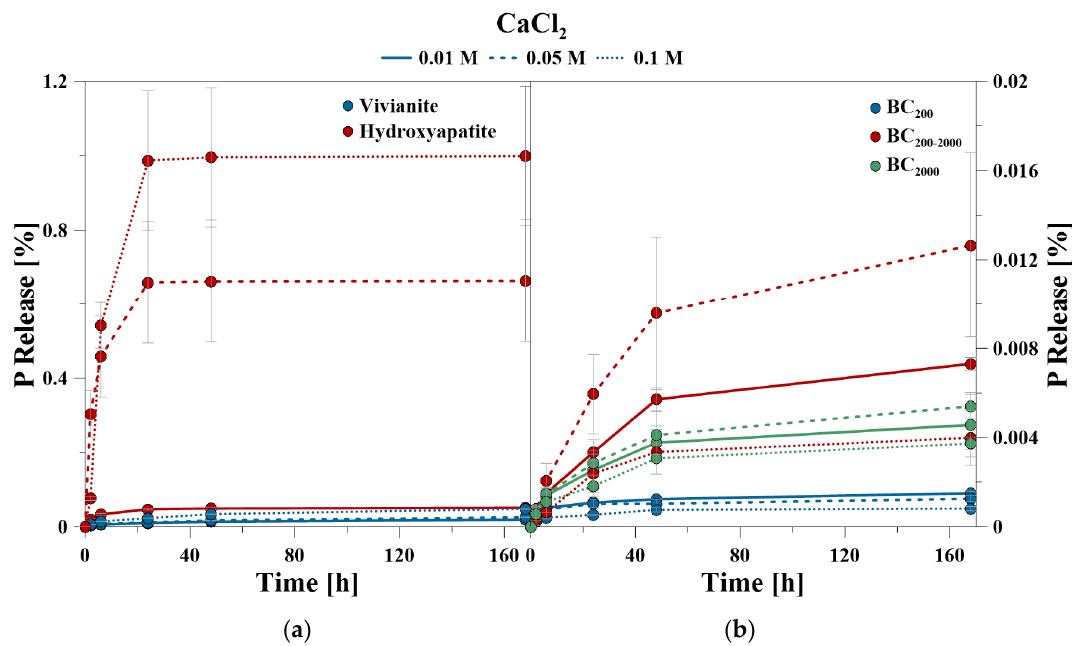
Figure 1. P release kinetics of ( a ) hydroxyapatite and vivianite as well as ( b ) bone char using CaCl 2 at pH 6.